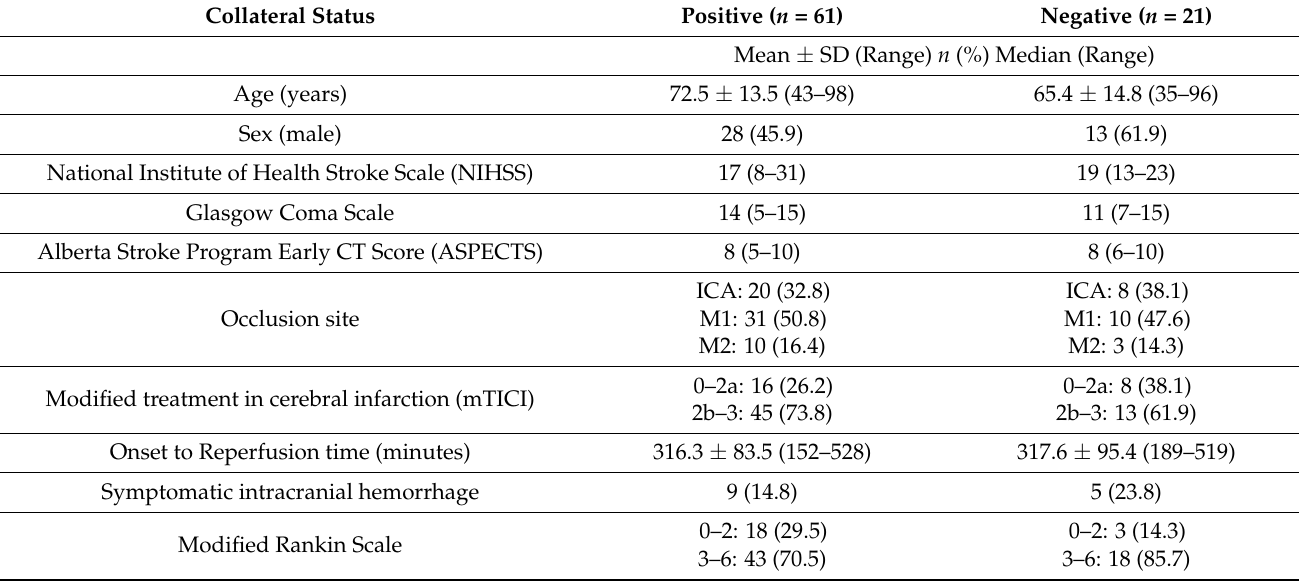
Table 1. Demographic data of the enrolled subjects with a positive or negative collateral